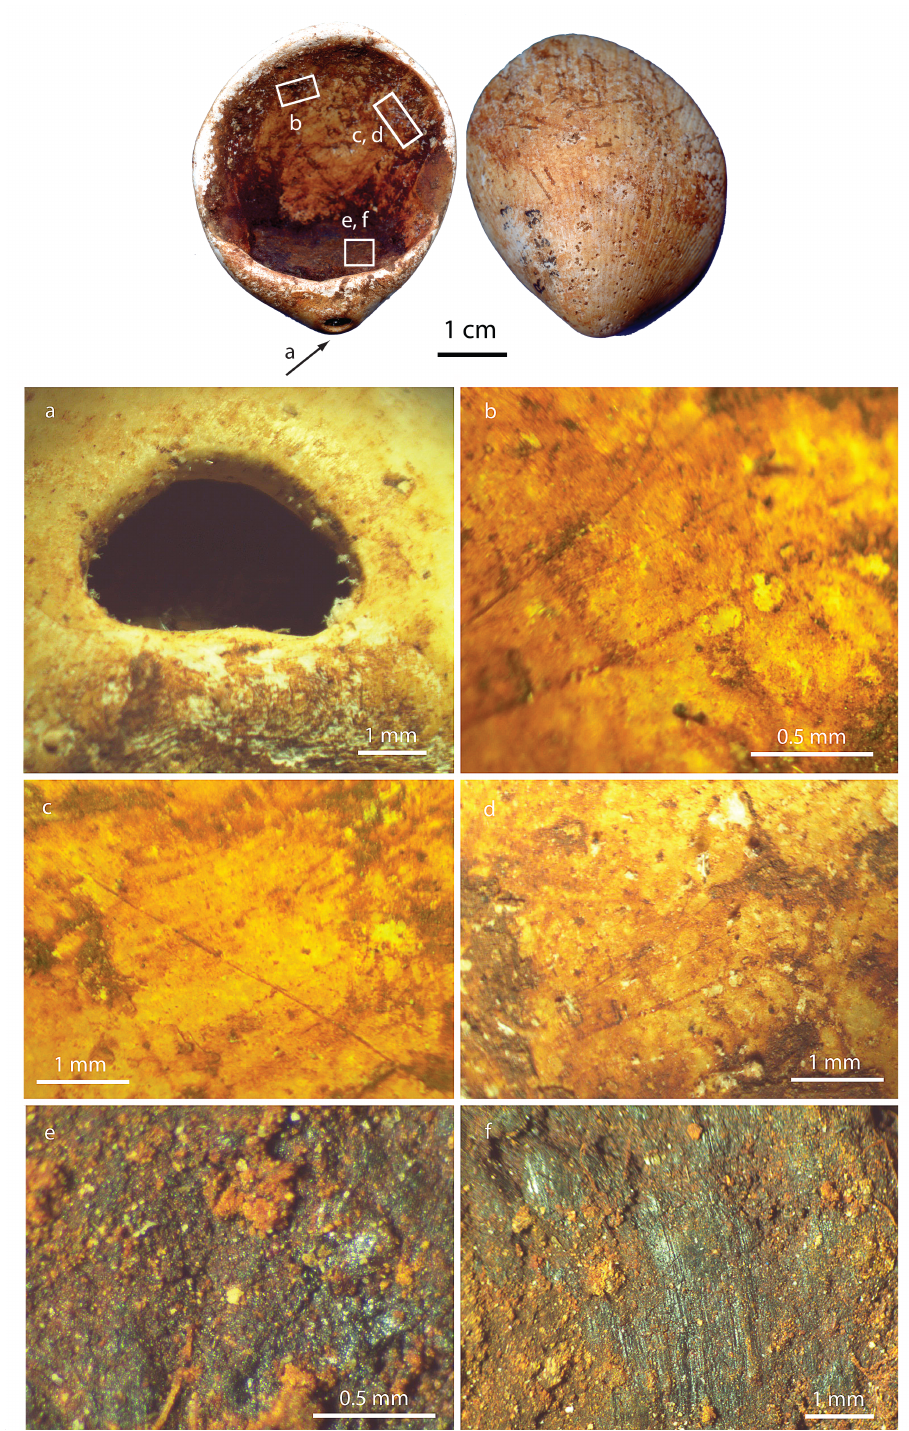
Figure 4: Natural perforation present on the umbo of a Glycymeris shell (a), striations on the ventral margin of the shells (b-d), close view of the red compound (e), and parallel striations present on the surface of the residue